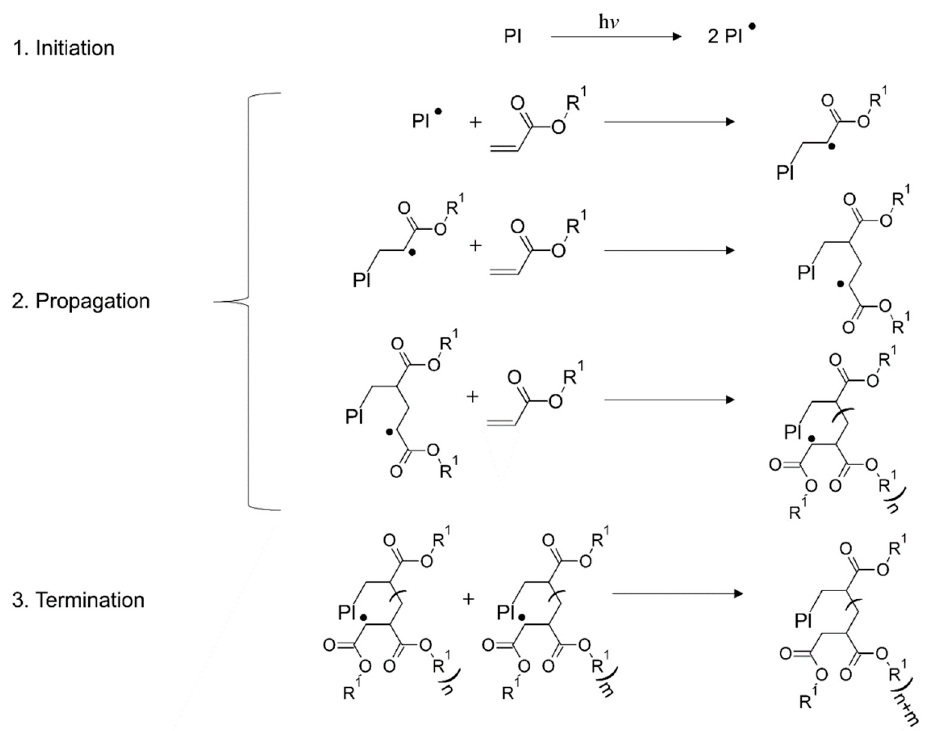
Figure 17. Schematics of radical-induced chain growth polymerization of acrylates. The termination stage is represented here only with a combination step. Reproduced with permission from [206]. Copyright © 2022 Elsevier.